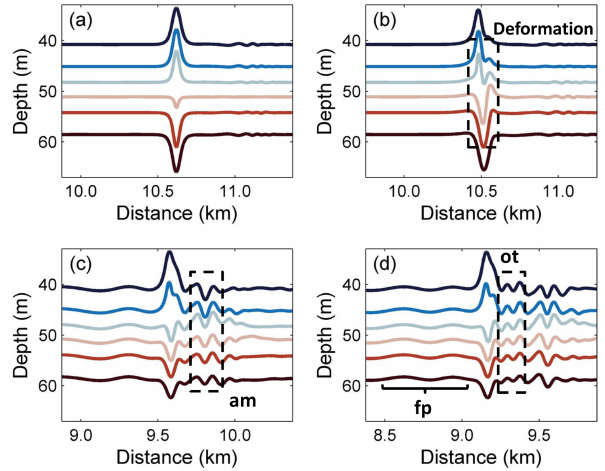
Figure 5. The evolution process of the vorticity field (s − 1 ) in case O5 ( (cid:49) = 0) for the different times (a) 0 T , (b) 1.2 T , (c) 10 T , and (d) 14 T , where “am” and “ot” denote the amplitude-modulated wave packet and oscillating tail,